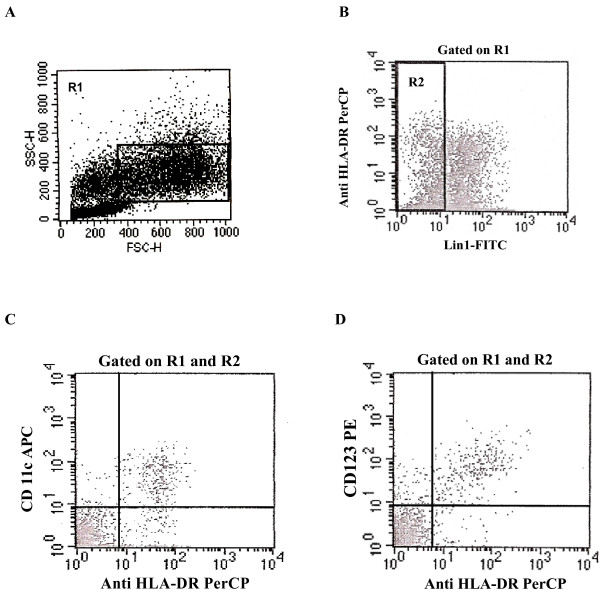
Quantification of dendritic cell subsets in cervical mucosa by flow cytometric analysis. (A) Introduction of an acquisition gate (R1) on the forward-scatter (FSC) versus side-scatter (SSC) profile to select mononuclear cell population. (B) cervical DCs were identified within gate R2 as lineage fluorescein isothiocyanate (FITC) cocktail (contains anti-CD3, CD14, CD16, CD19, CD20, and CD56) negative and HLA-DR positive. (C-D) Detection of HLA-DR+ CD11c+ myeloid DCs and HLA-DR+CD123+ plasmacytoid DCs respectively. FSC, forward scatter; SSC, side scatter; PerCP, peridin chlorophyll protein; PE, phycoerythrin; APC, allophycocyanin.